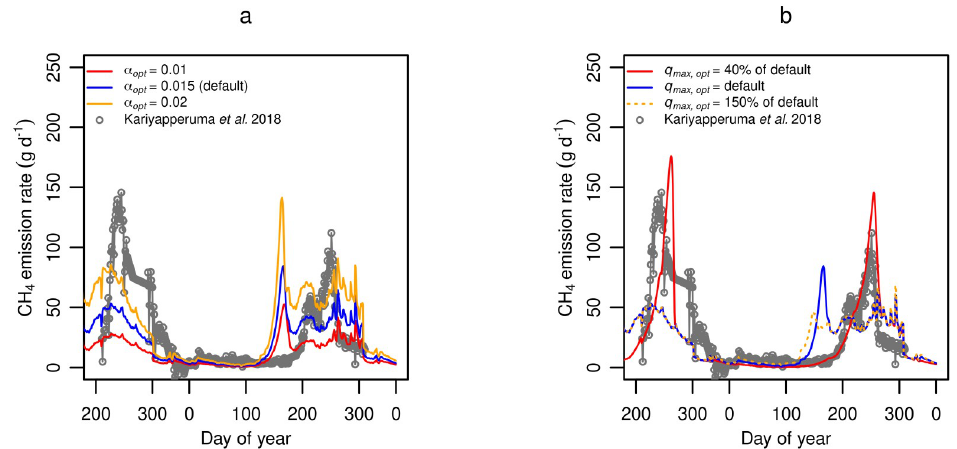
Fig 9. Model application to case study. Model results versus measured [6] CH 4 emission from a full scale slurry tank with periodic slurry introduction applying different (a) hydrolysis rates ( α opt ) and (b) maximum substrate utilization rates at optimum temperature ( q max , opt